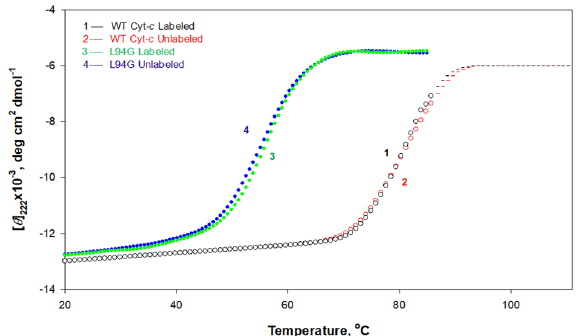
Figure 4. Thermal denaturation of WT cyt c and its mutant L94G at pH 6.0. Denaturation was monitored by [ θ ] 222 . Each dotted line is drawn with best fitted parameters according to Eq. (2).